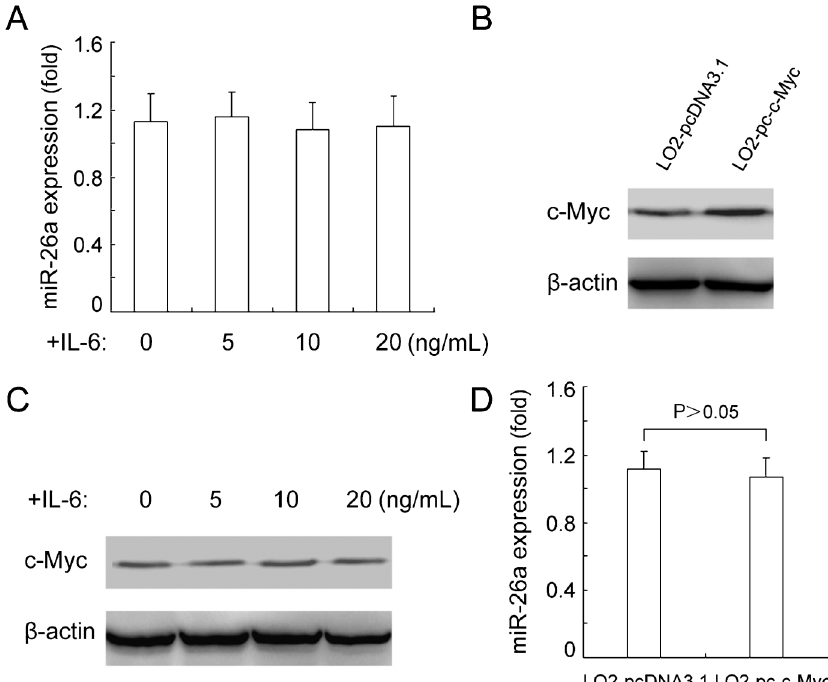
Figure 4. IL-6 stimulation does not affect the expression of miR-26a in LO2 cells. A , Quantitative RT-PCR showed that miR-26a expression in LO2 cells was not modified upon IL-6 stimulation (N = 5, P . 0.05). B , Expression of c-Myc protein in LO2-pc-c-Myc cells. C , Representative immunoblots also showed that c-Myc expression was not changed by IL-6. D , Expression of miR-26a in LO2- pc-c-Myc cells. Compared with the expression of miR-26a in control LO2-pcDNA3.1 cells, the expression of miR-26a in LO2-pc-c-Myc cells was not significantly modified (N = 5, P .